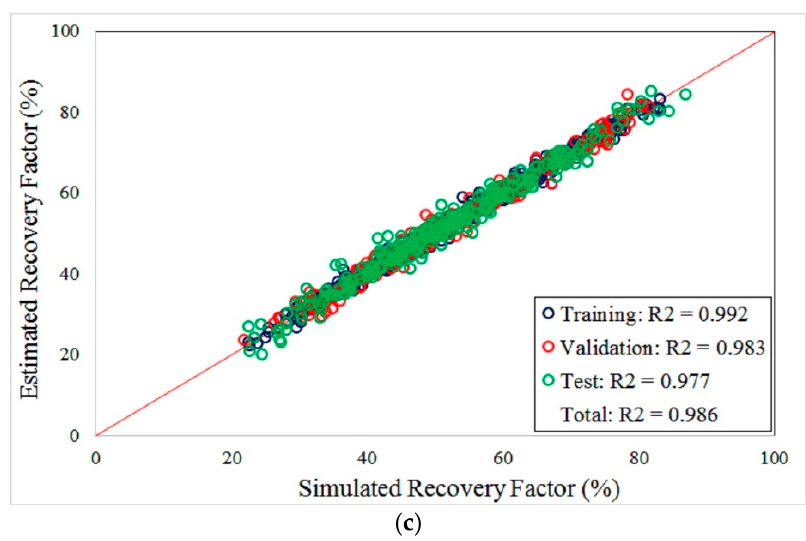
Figure 6. Estimation results for recovery factor by ANN of three schemes: ( a ) 60%-20%-20%; ( b ) 55%-20%-25%; ( c ) 50%-20%-30%. The rise of data set for testing reduces the accurate estimation in blind